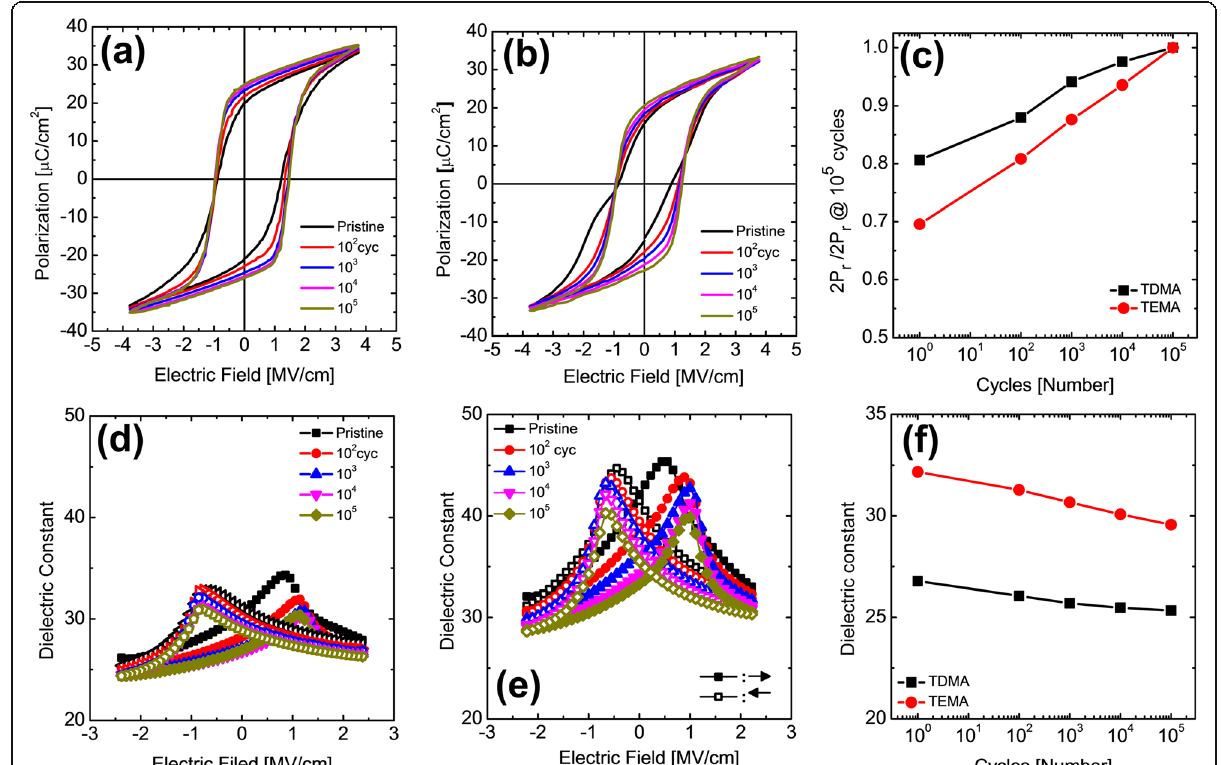
Fig. 2 The polarization – electric field (P – E) curves of ( a ) the TDMA HZO and ( b ) TEMA HZO (reproduced from Ref. [5]) capacitors measured in pristine state and fatigued states pulsed by 10 2 , 10 3 , 10 4 , and 10 5 times at 3.8 MV/cm-high and 10 μ s-wide bipolar rectangular pulses. ( c) The changes in 2P r values of TDMA (black) and TEMA (red) HZO capacitors as a function of fatigue pulses. The dielectric constant – electric field curves of ( d ) the TDMA HZO and ( e ) TEMA HZO (reproduced from Ref. [5]) capacitors with the top and bottom TiN electrodes measured in pristine state and fatigued states. ( f) The changes in dielectric constant values with increasing number of fatigue pulses for TDMA (black) and TEMA (red) HZO